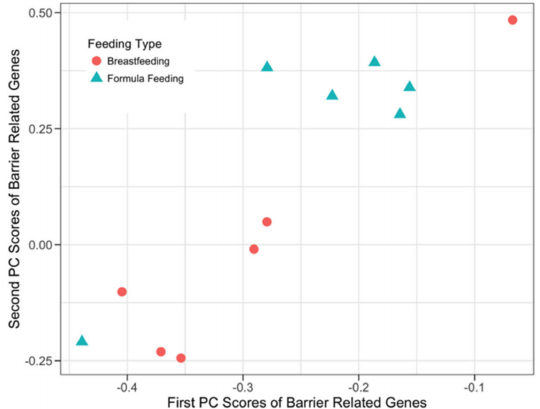
Figure 5. sPCA plot for barrier-related host genes. The x-axis and the y-axis represent the first and the second principal components obtained after the sPCA application to the normalized barrier-related host genes. A total of 24 out of 52 host barrier function-related genes participated in the first two principal